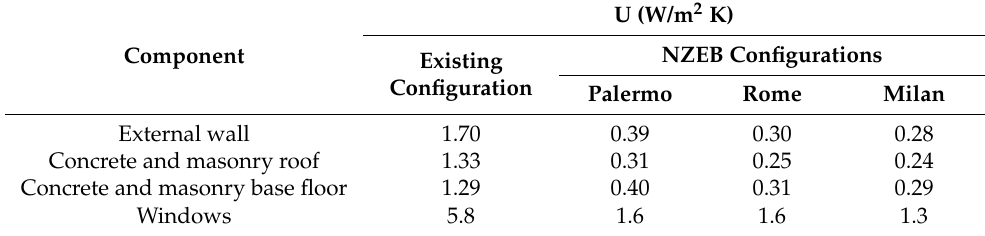
Table 2. U-values for the RB configurations: existing and retrofitted depending on the Italian location. U (W/m 2 K) NZEB Component Existing Configuration